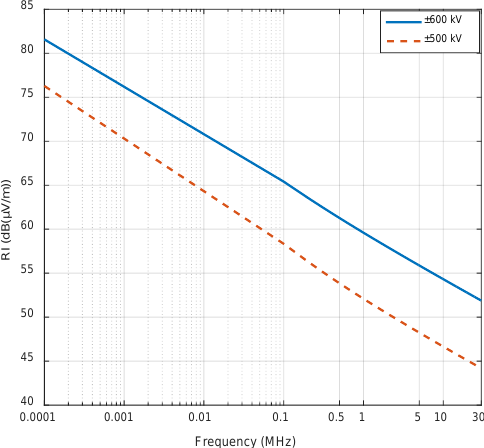
Figure 8. RI as a function of the soil resistivity.